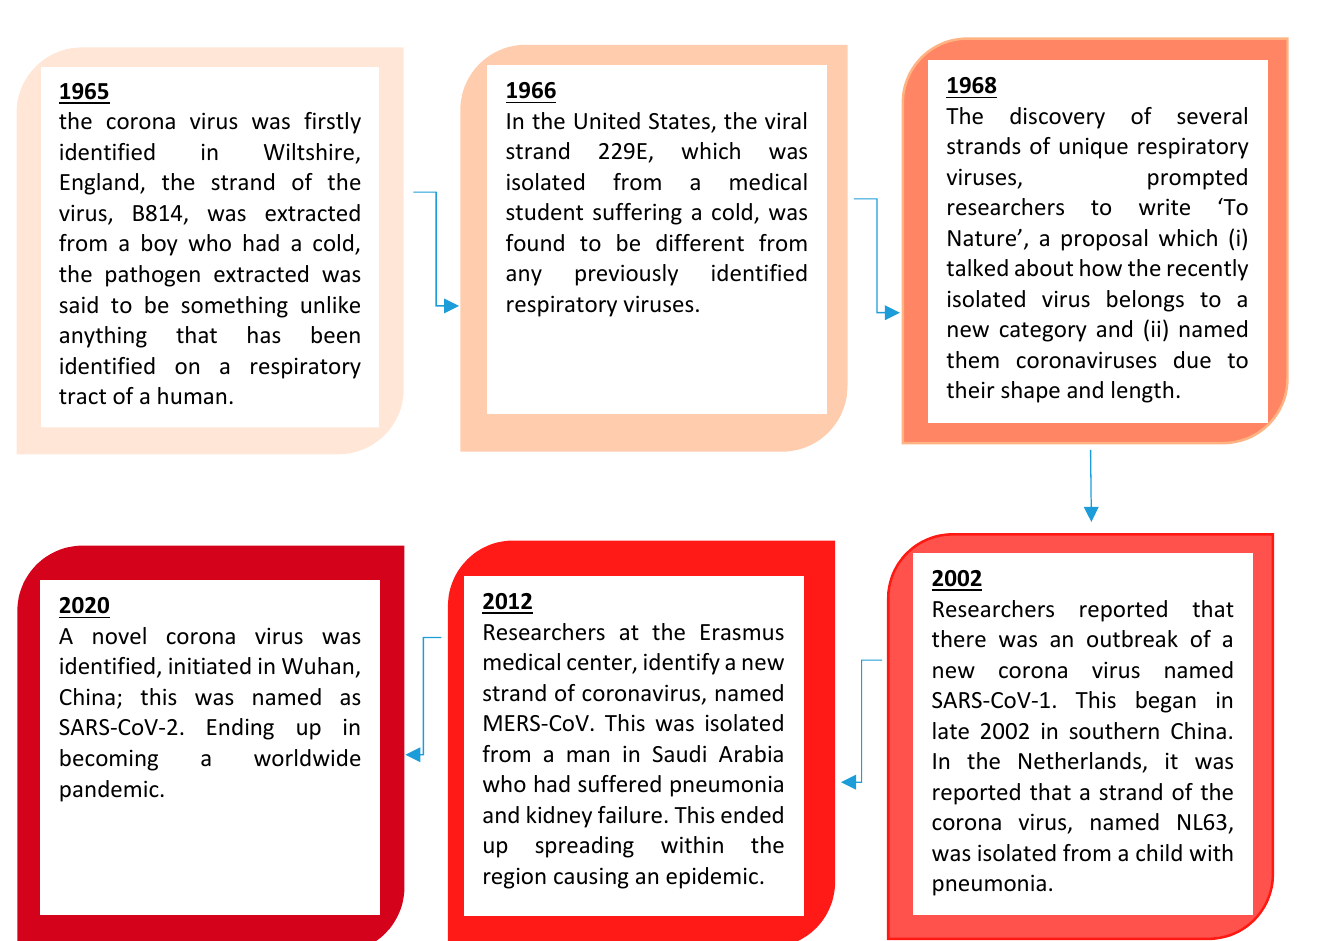
Figure 3. Brief timeline history of the Ortho-Coronavirinae as illustrated by Williams 2020 [26] Vaccinations proposed for SARS-CoV-1